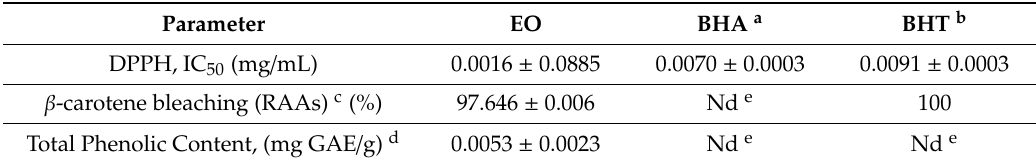
Table 6. Total phenolic content, ß -carotene bleaching and DPPH radical scavenging activities of the EO extracted from P. sylvestris